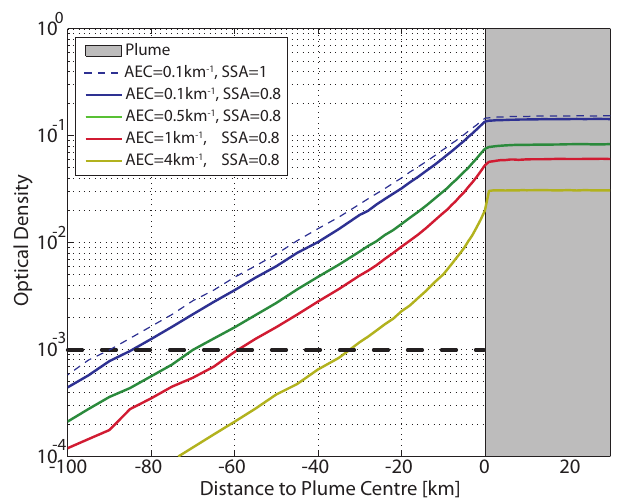
Fig. 14. Optical densities are shown for model scenario B1 in order to assess detectability of large scale volcanic cloud. Optical densities of more than 10 − 3 are still obtained at distances greater than 80km from the plume for the wavelength range 310–315nm, thus indicating the possibility of a significantly earlier detection than is possible at lower altitudes.